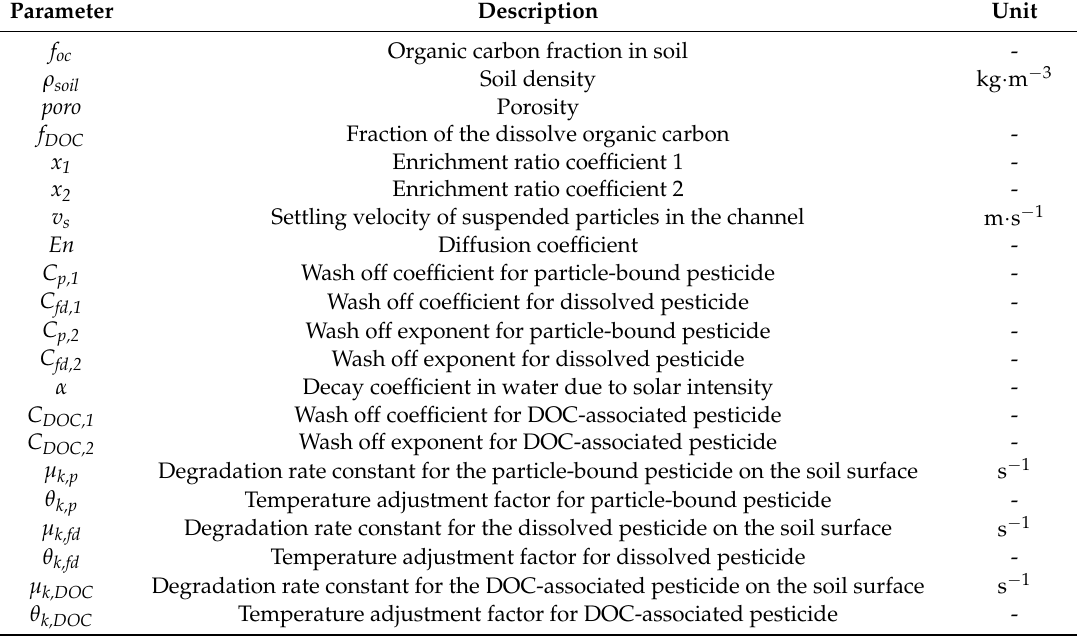
Table 4. Pesticide parameters for calibration and sensitivity analysis of the modified model.